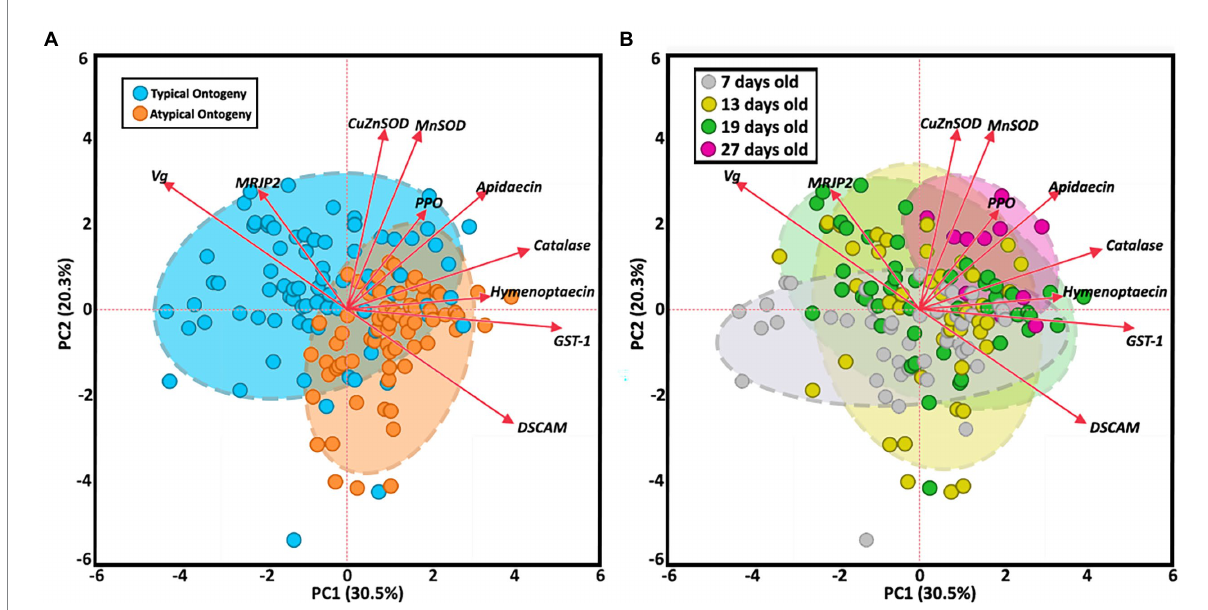
FIGURE 3 Principal component analysis of fat body gene expression by both ontogeny (A) and age (B) . Clustered groups of points contain similar gene expression. Longer vectors result from greater variation in gene expression. Density ellipses cover 90% of plots for each